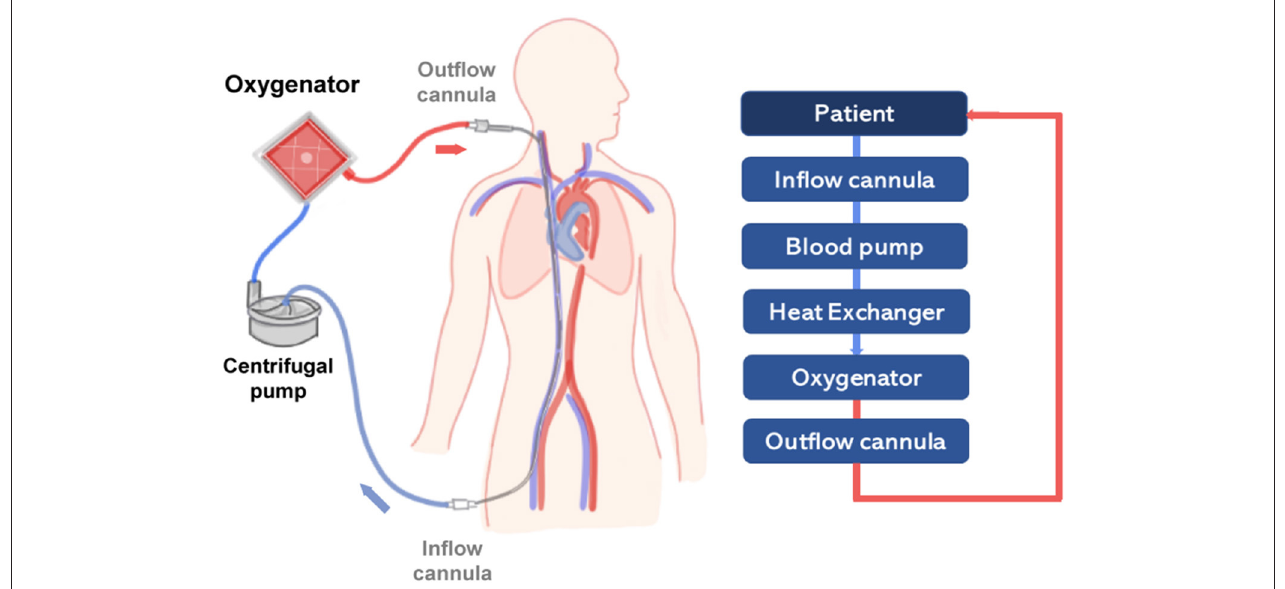
FIGURE 2 | Scheme representing a simplified VV-ECMO circuit, providing partial to complete pulmonary support in severe respiratory failure. On the right side, a diagram represents the main components of the circuit (light blue boxes) connected to the patient (dark blue box). The flow of oxygenated blood is represented by a red line and deoxygenated blood by a blue